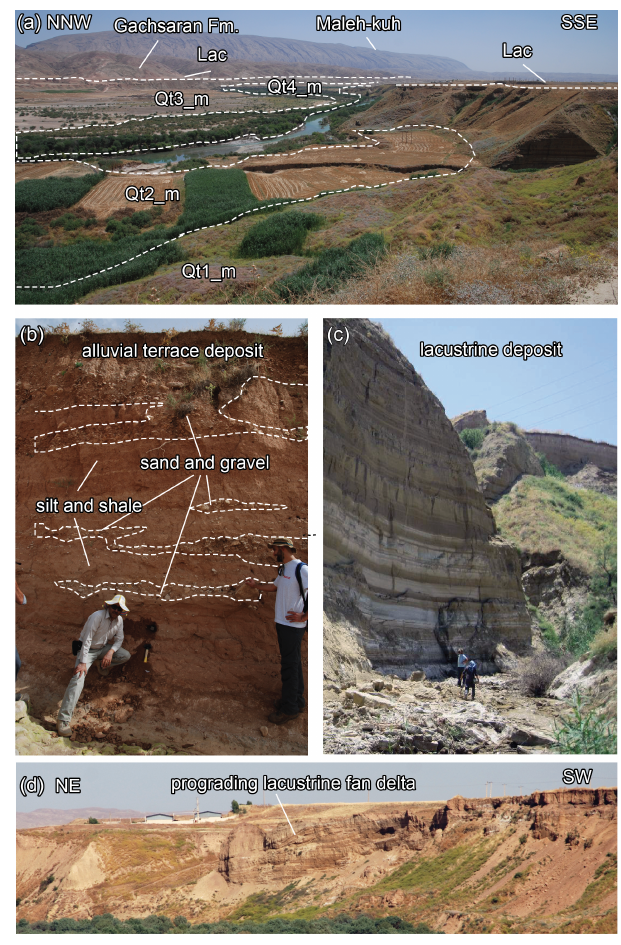
Figure 5. Geomorphic markers upstream of the Seymareh land- slide, represented by a suite of four orders of alluvial terraces en- trenched in the lacustrine deposits (Lac) of Seymareh Lake up- stream of the landslide, in the areas where Harrison and Fal- con (1938), Roberts and Evans (2013), and Shoaei (2014) hypothe- sized the natural damming lake could be extended. (a) Overall view of the suite of terraces; (b) example of fluvial terrace deposit; (c) ex- ample of lacustrine deposit; (d) evidence of a prograding lacustrine fan delta formed by one of the right tributaries of Seymareh Lake during its early emptying